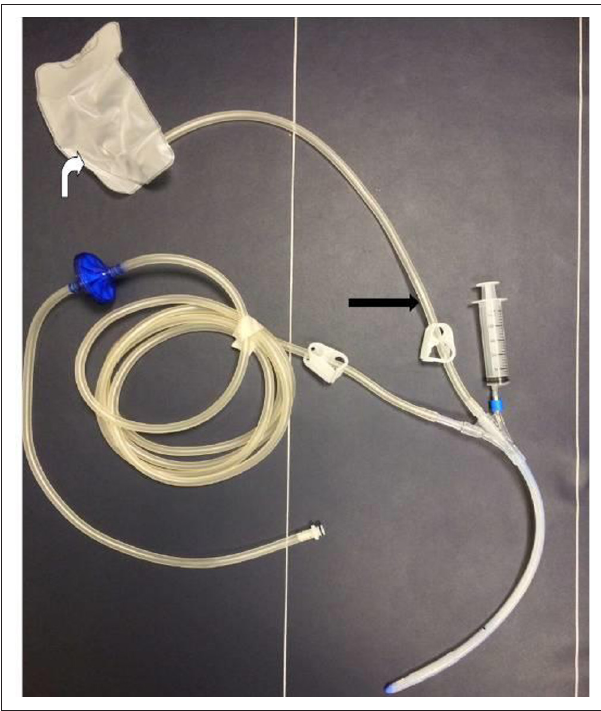
FIGURE 2: Three-way connection. Rectal drainage (black arrow). Rectal drainage bag (white arrow).